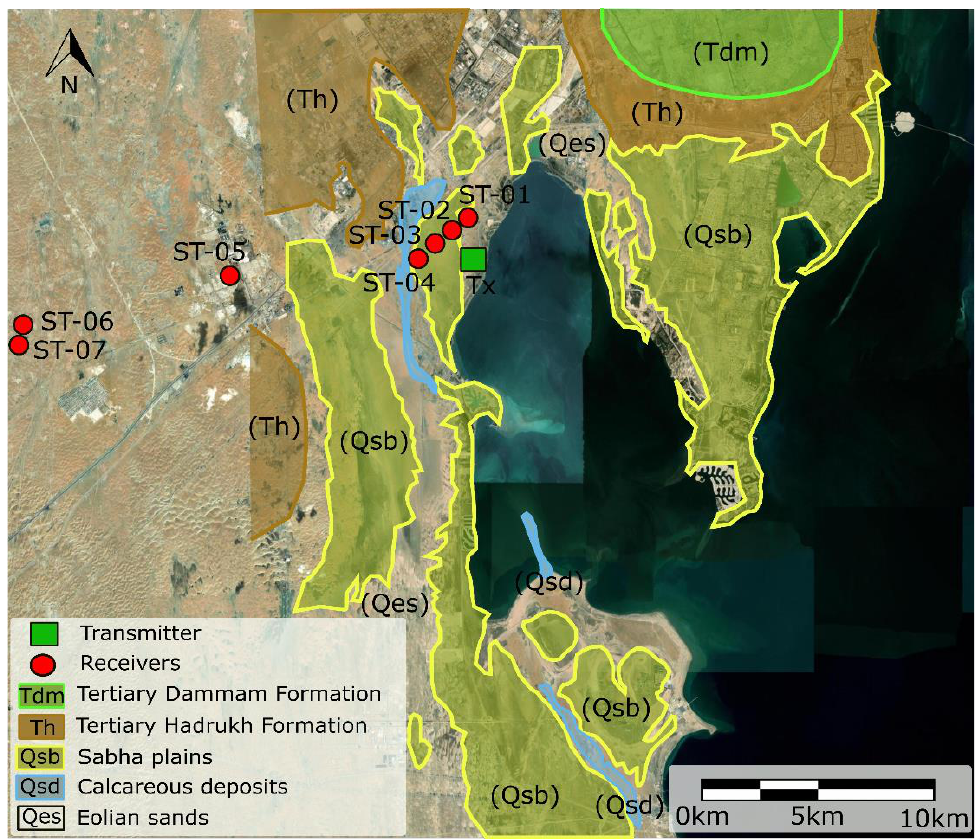
Figure 1. Geologic map of the study area with the transmitter (red circle) and receivers’ (green squares) locations. The transmitter (Tx) has a length of 1.1 km. The receiver sites were used for CSEM and MT measurements at different time periods.